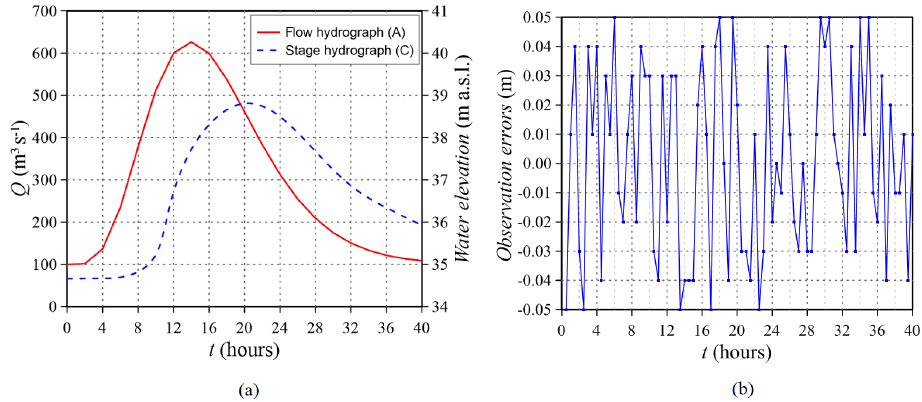
Figure 8. Parma River: flow and stage hydrographs at sections A and C, respectively, (a) and observation error distribution (b) .